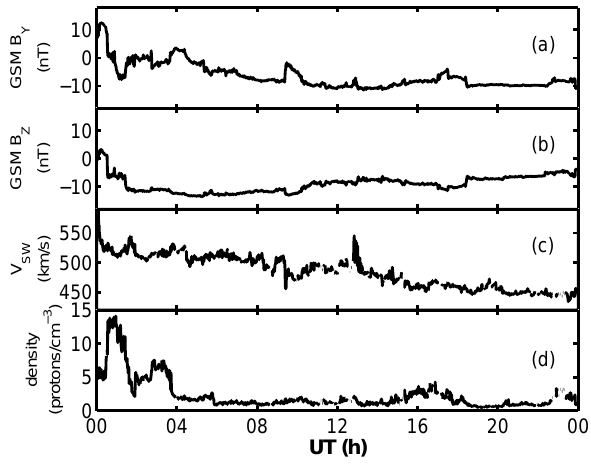
Fig. 2. Solar wind parameters from the ACE spacecraft: (a) IMF B Y in GSM; (b) IMF B Z in GSM; (c) solar wind speed; (d) so- lar wind proton density. These data have been propagated to the bowshock via a minimum variance analysis technique.